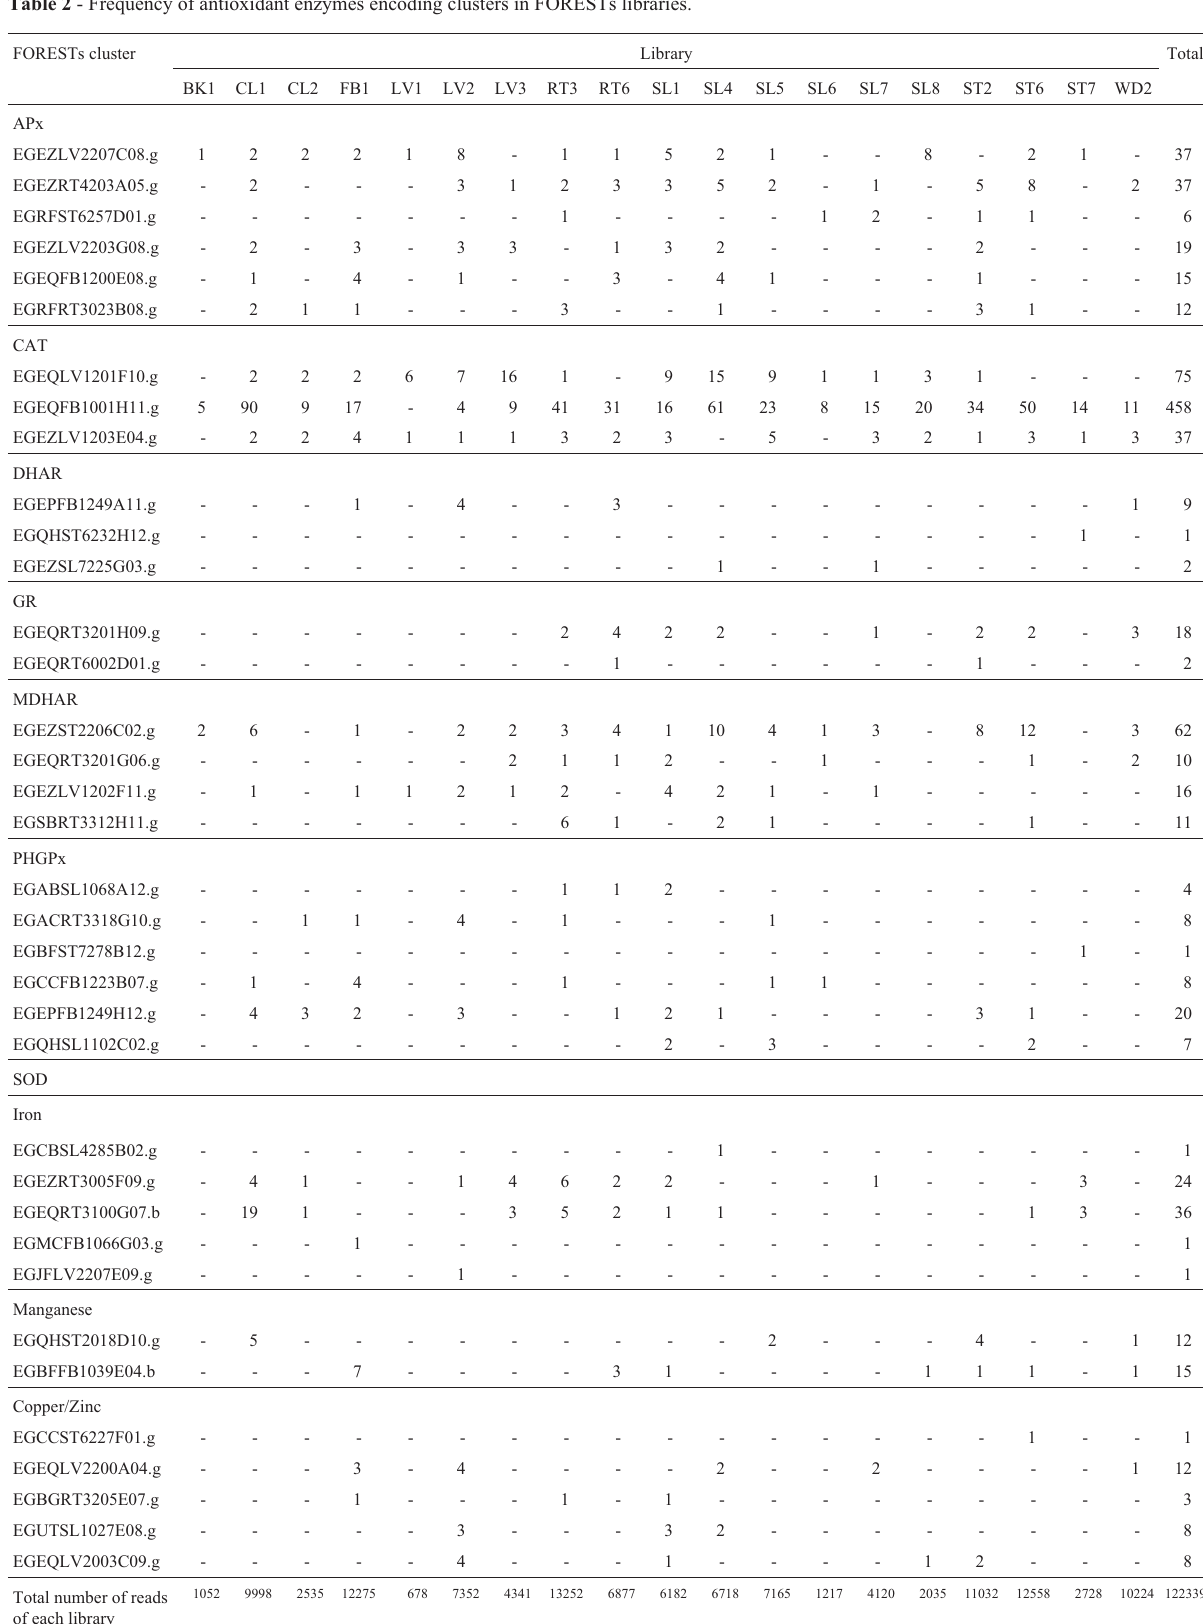
Table 2 - Frequency of antioxidant enzymes encoding clusters in FORESTs libraries. FORESTs